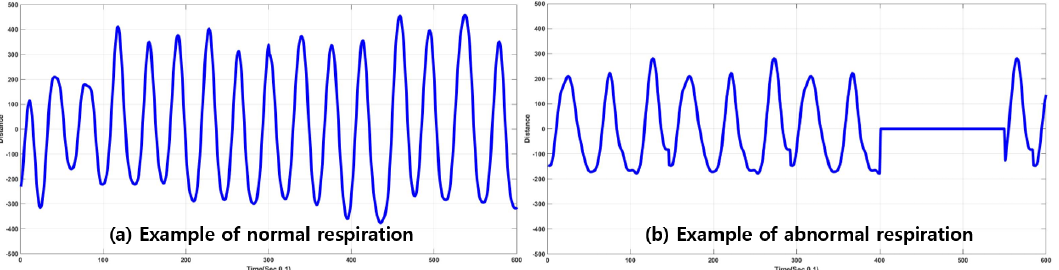
Figure 2. Ultrawide-band (UWB) radar detect motion of chest surface and generates quantitative data that describe distance variation during exhalation and